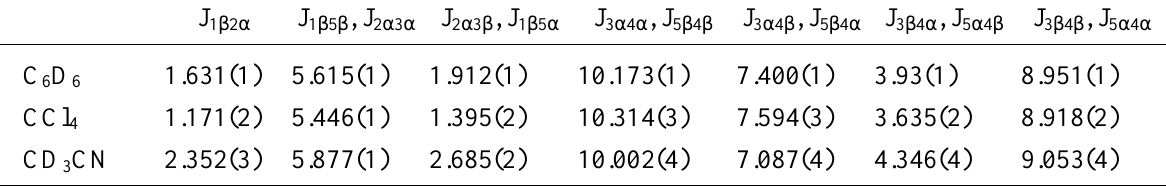
Table 2. Vicinal proton-proton coupling constants in trans-1,2-dibromocyclopentane